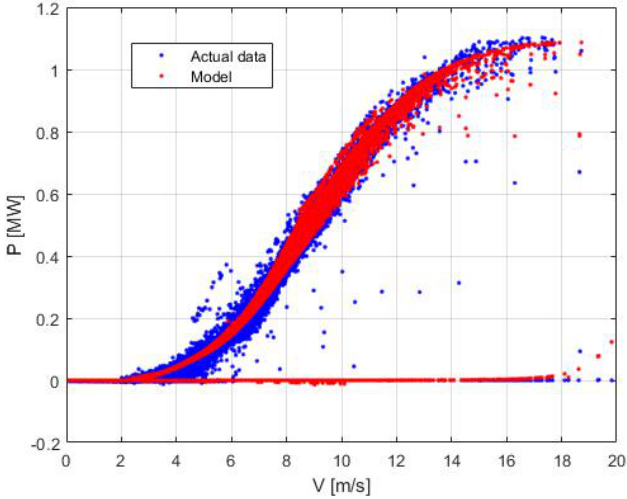
Figure 26. Energy production forecast for wind power plant